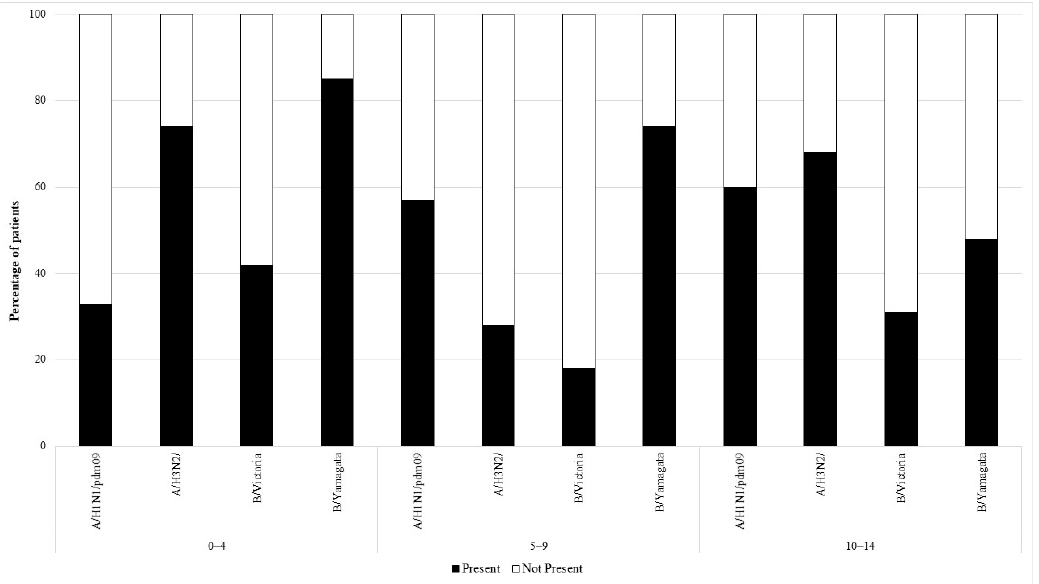
Figure 1. The presence of antibodies in the serum of patients aged 0–4 years, 5–9 years of age, and 10–14 years of age in the 2019/2020 epidemic season.